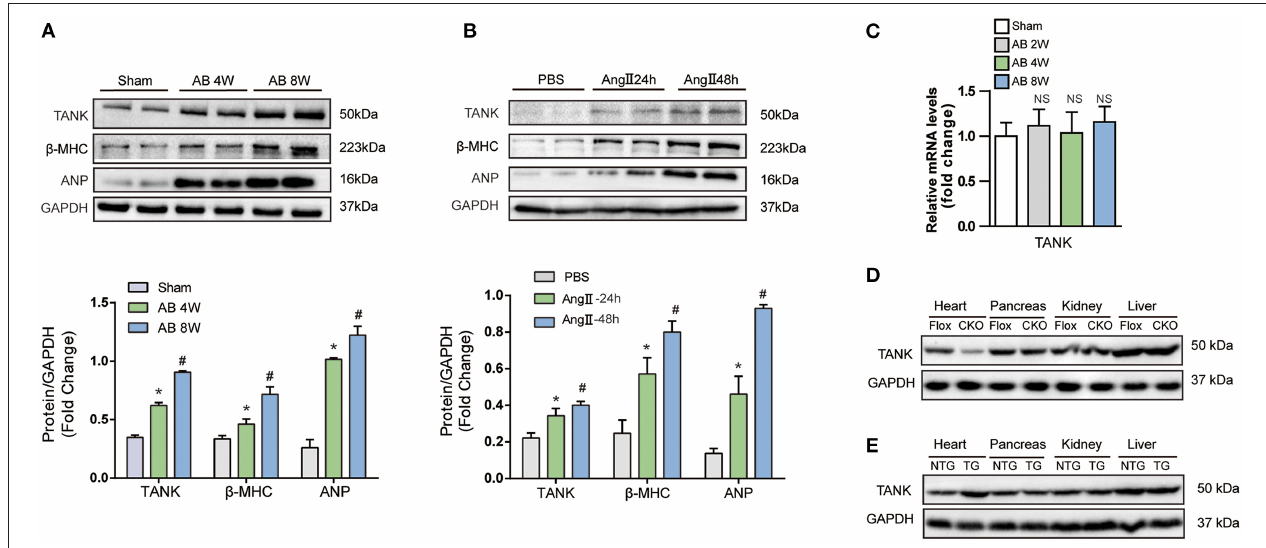
FIGURE 1 | The expression of TANK is upregulated in hypertrophic murine hearts. (A) Western blot analysis of TANK expression in cardiac extracts of samples from mice subjected to aortic banding at the indicated time points ( n = 6 mice per experimental group). (B) TANK expression was analyzed by western blotting in extracts from neonatal rat cardiomyocytes treated with angiotensin II (Ang II; 1 µ mol/L) for 24 and 48h ( n = 3 independent experiments). * P < 0.05 vs. Sham or vs. PBS; # P < 0.05 vs. AB 2w or vs. Ang II 24h. The data are presented as the mean ± SD. (C) mRNA levels of the TANK in heart samples from sham group and mice after aortic banding 2weeks, 4weeks and 8weeks ( n = 3 per mice group). (D) Western blot showing TANK expression in TANK specific deleted heart, pancreas, kidney and liver. (E) TANK protein expression in heart samples and other tissue from TANK transgenic mice.